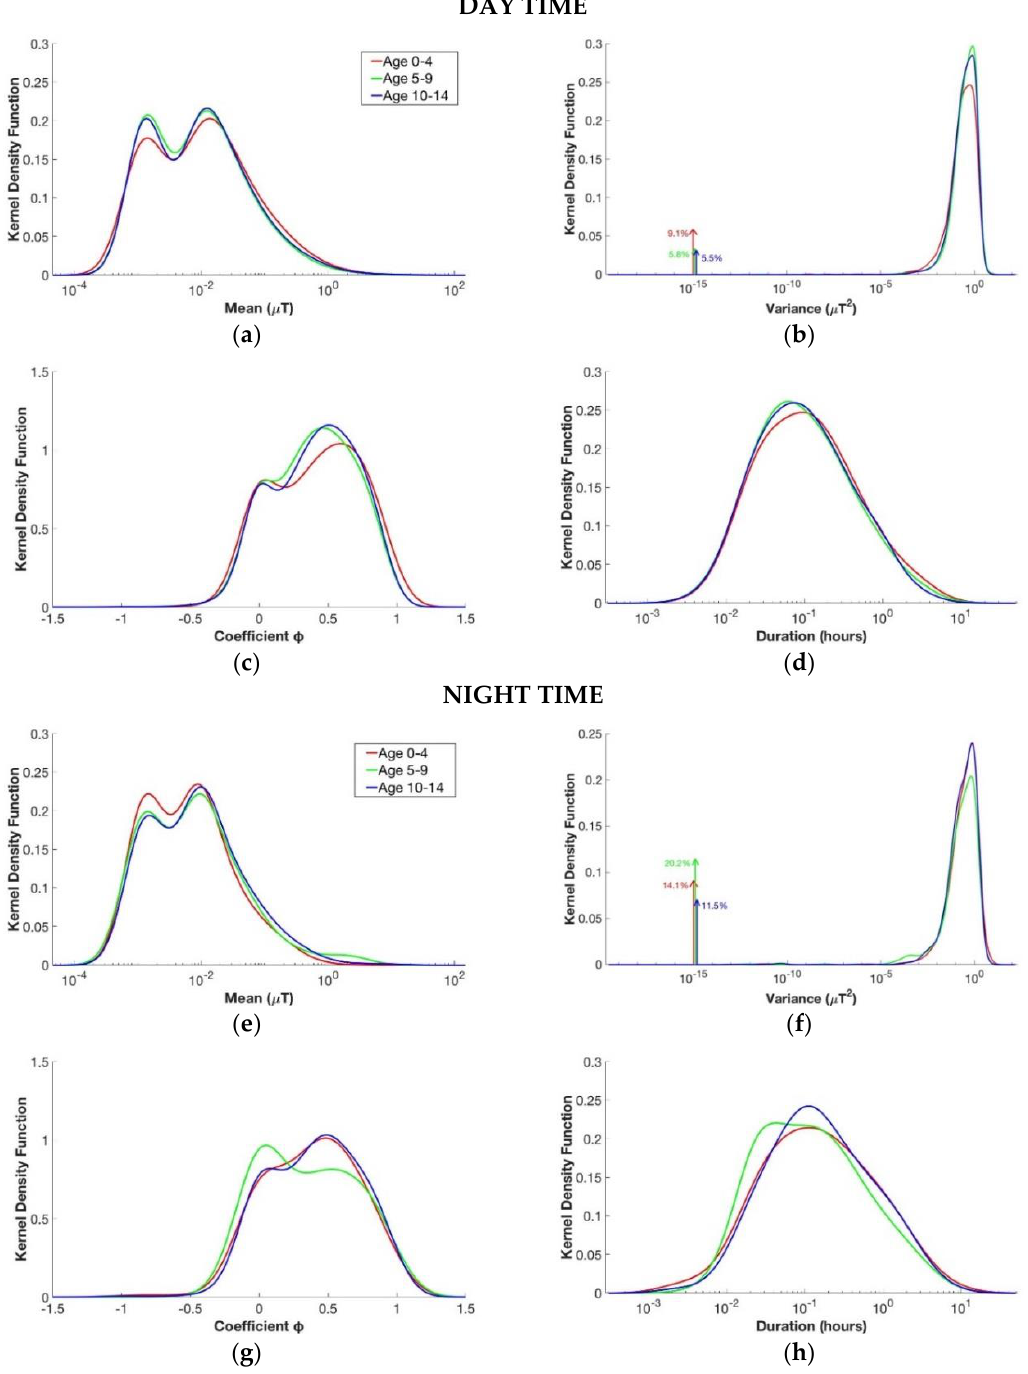
Figure 4. Estimated kernel density function for the four variables of the segments of the day in the upper part and for the segments of the night in the lower part. From above to down, left to right: ( a , e ) mean µ , ( b , f ) variance σ 2 , ( c , g ) coefficient ϕ , and ( d , h ) duration T. The groups considered are children with age between 0 and 4 years old (in red), children with age between 5 and 9 years old (in green), and children with age between 10 and 14 years old (in blue).